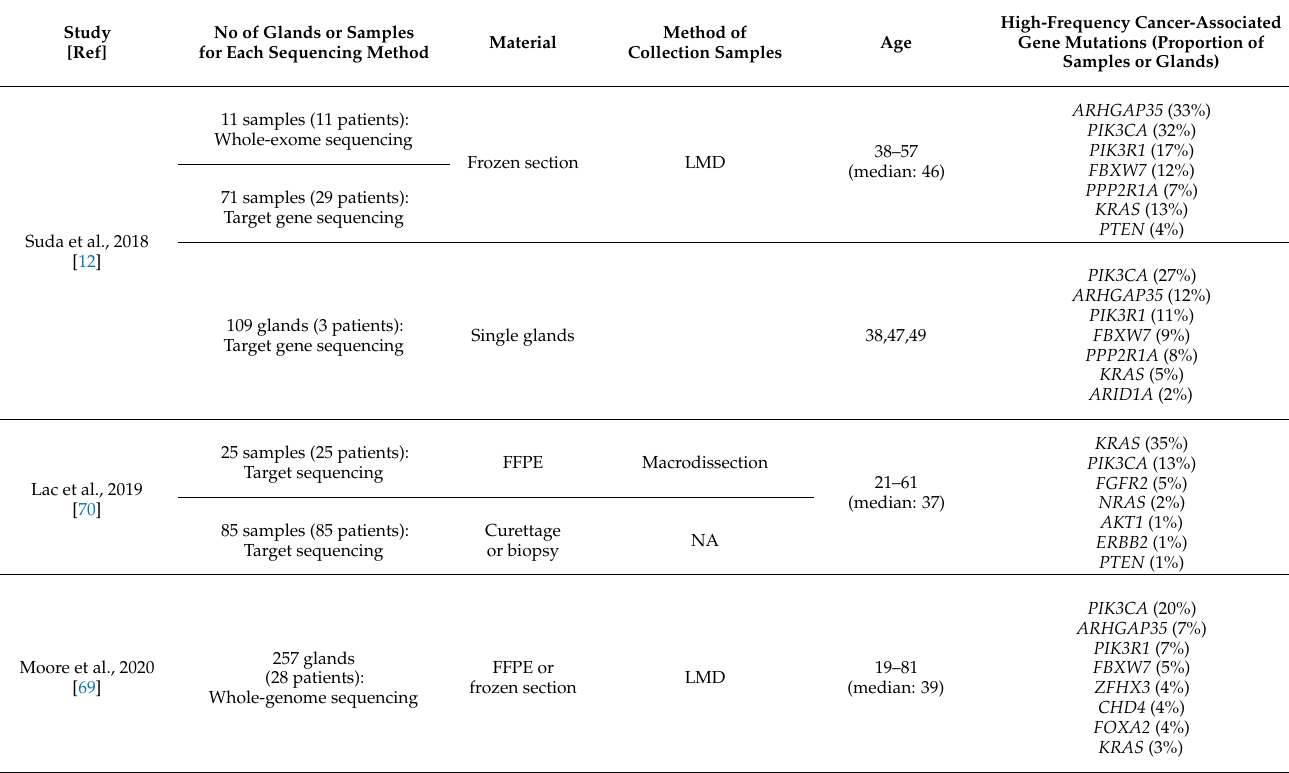
Table 4. Summary of genomic alterations in uterine